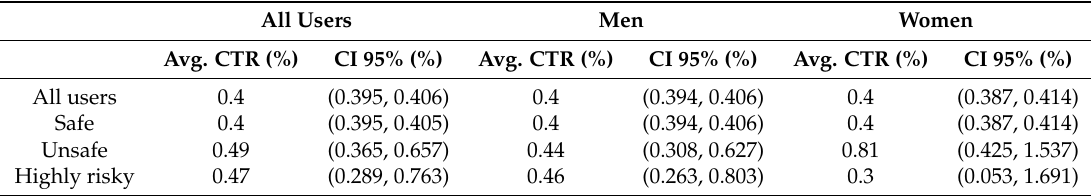
at the 95% level using the Wilson Score Interval method. The CTR is reported in percentage. The table includes the results for level All, Safe, Unsafe, and Highly Risky ads retrieved from the FDVT